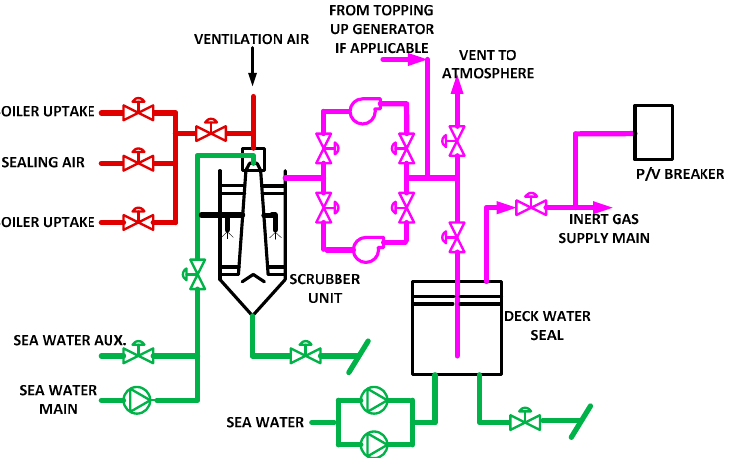
Figure 5. Inert gas/flue gas aqueous scrubbing system with seawater. (Figure was genuinely generated using data from refs. [36,38]).